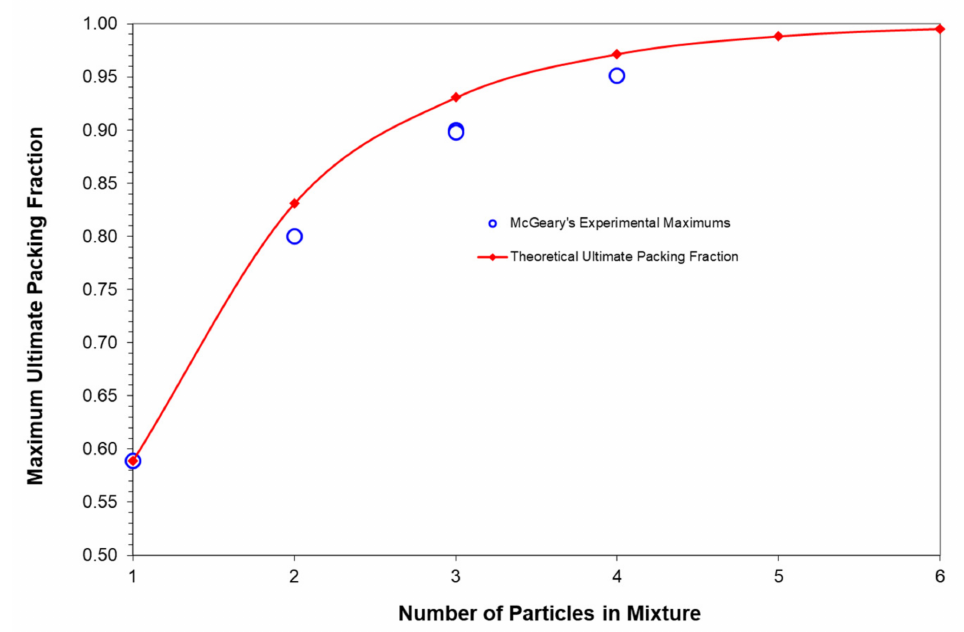
Figure 3. McGeary’s maximums and theoretical maximums vs. number of